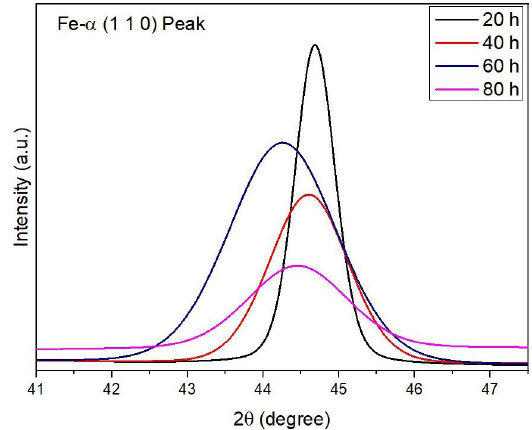
Figure 11. Detail of the (110) Fe-α peak analysis for different milling times for Fe-15at.%Nb samples with methanol PCA.